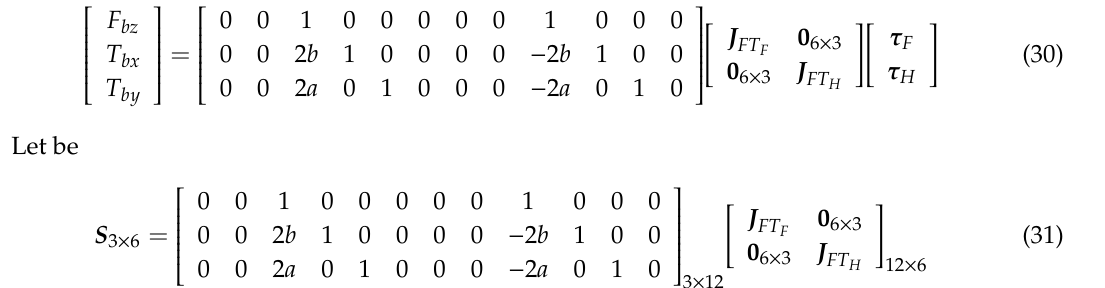
Figure 14. The pitching hip joint position tracking curves of the RF leg of the robot. ( a ) Response curves; ( b ) Local amplification curves.